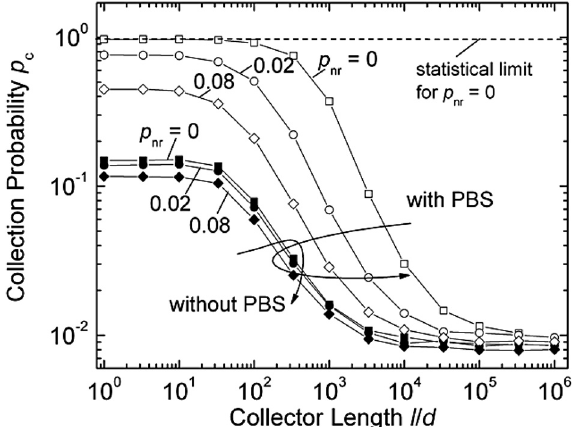
Fig. 5. Collection probability p c of the fluorescent collector ge- ometry with solar cells mounted at the bottom of the collector (Fig. 1c). The coverage fraction f is kept constant at f = 0 . 01 and the normalized collector length l/d is varied. All data fea- ture a transition between two asymptotic situations at low and high ratios l/d . Only the systems with a photonic band pass (PBS, full symbols) achieve p c > 0 . 5 at low ratios of l/d . For these systems, the maximum p c as well as the transition from the small-scale to the large-scale behaviour is strongly depen- dent on the non-radiative recombination probability p nr . The systems without PBS (open symbols) have already a relatively low p c < 20% even in the more favorable case of l/d < 10. Ac- cordingly, the sensitivity to the introduction of non-radiative recombination in the dye ( p nr > 0) is less